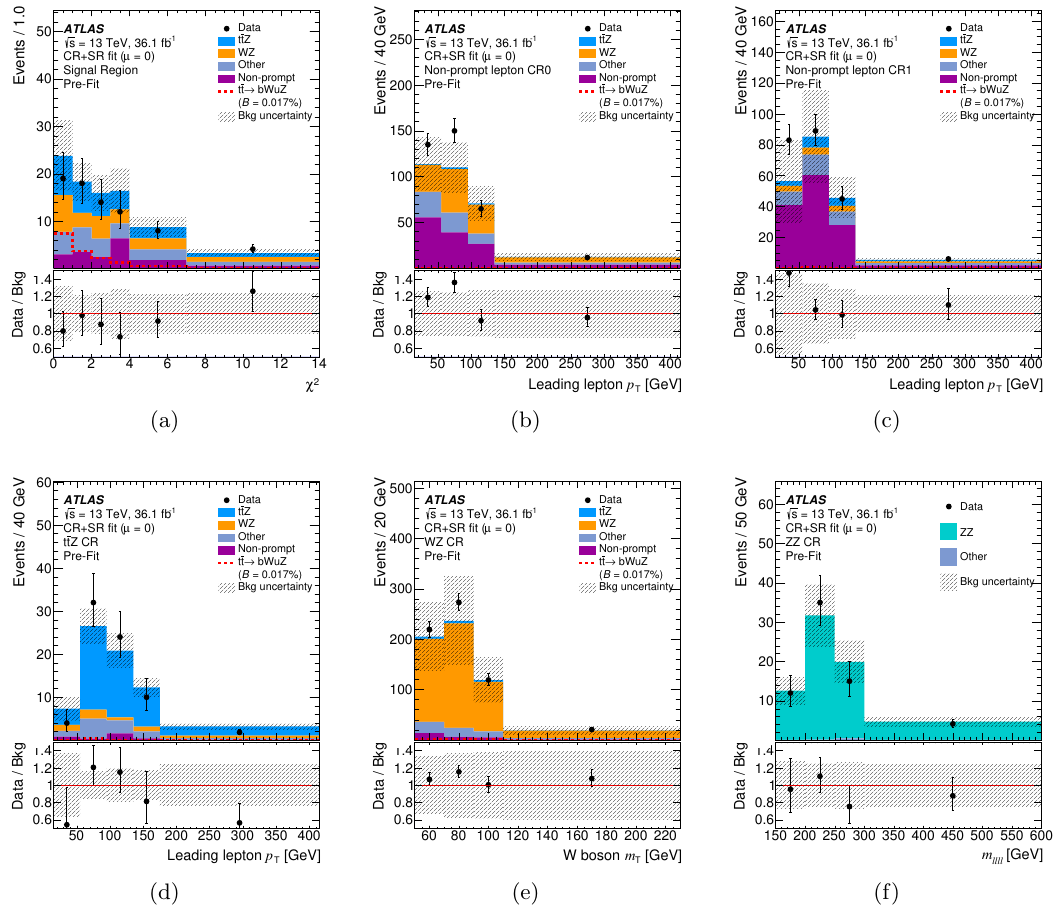
Figure 2 . Expected ((cid:12)lled histogram) and observed (points with error bars) distributions before the combined (cid:12)t under the background-only hypothesis of (a) the (cid:31) 2 of the kinematical reconstruction in the SR; (b) p T of the leading lepton in the non-prompt lepton CR with b -tag veto; (c) p T of the leading lepton in the non-prompt lepton CR with b -tag; (d) p T of the leading lepton in the t (cid:22) tZ CR; (e) the transverse mass in the WZ CR and (f) the reconstructed mass of the four leptons in the ZZ CR. For comparison, distributions for the FCNC t (cid:22) t ! bWuZ signal (dashed line), normalized to the observed limit, are also shown. The \Other" category includes all remaining backgrounds described in section 3. The dashed area represents the total uncertainty in the background prediction.